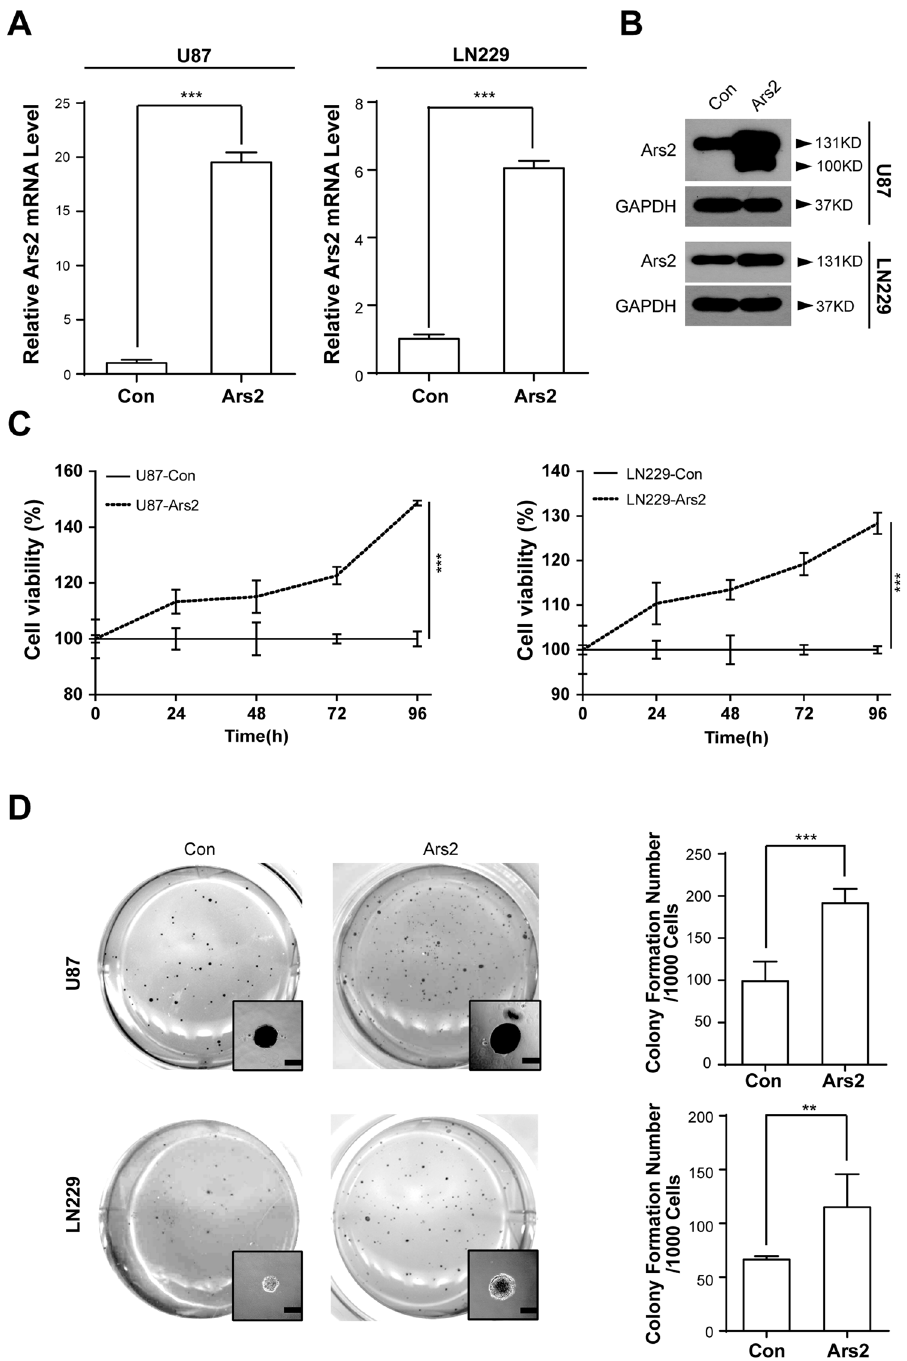
Figure 2. Ars2 promoted cell proliferation and colony formation in glioblastoma cells. U87 and LN229 cells were transfected with vector control and Ars2. ( A ) Total RNA was isolated and Ars2 mRNA was quantified using qRT-PCR analysis. ( B ) Western blot assay was used to detect the expression of Ars2 in U87-Con, U87- Ars2, LN229-Con, and LN229-Ars2 cells. ( C ) U87 cells and LN229 cells were seeded into a 96-well plate (1000 cells/well), and cell proliferation was determined by using MTT assay. ( D ) Colony formation in U87 cells and LN229 cells was detected by soft agar assay. All data were represented as the mean ± SD for three separate experiments, ** P < 0.01, *** P <